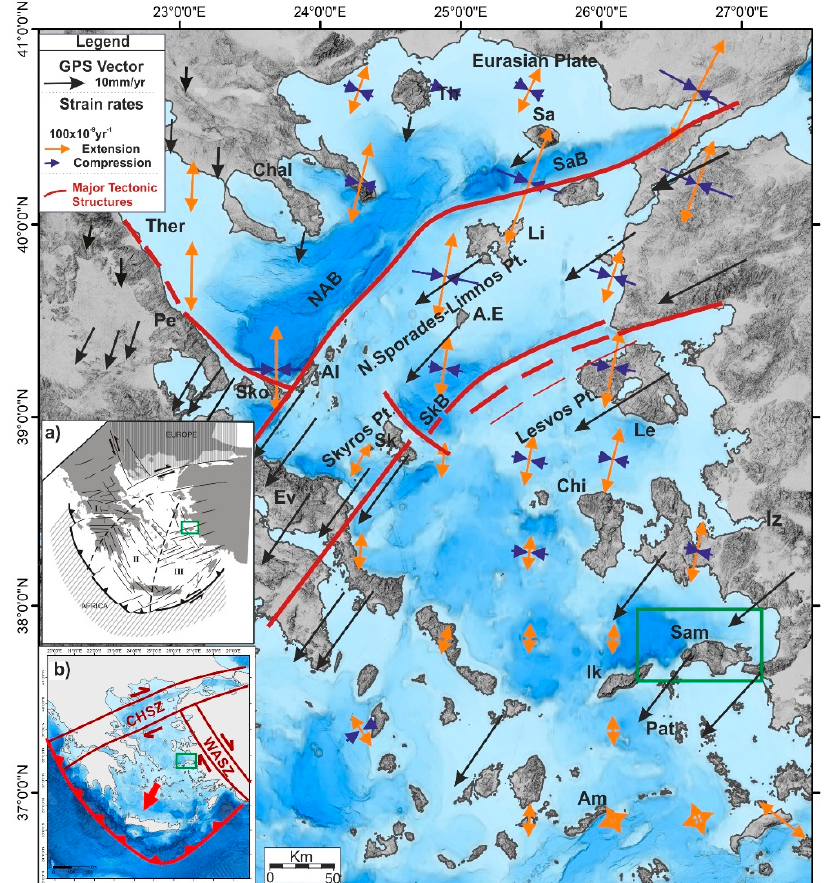
Figure 1. The location of Samos Island at the eastern Aegean Sea and the studied area in green frame. Red lines correspond to major tectonic structures and black arrows correspond to GPS vectors [16]. Orange and blue arrows correspond to geodetic strain rates [17]. A.E: Aghios Efstratios, Al: Alonnissos, Am: Amorgos, Chal: Chalkidiki, Chi: Chios, Ev: Evia, Ik: Ikaria, Le: Lesvos, Li: Limnos, Patm: Patmos, Pe: Pelion, Sa: Samothraki, Sam: Samos, Sko: Skopelos, Ther: Thermaikos, NAB: North Aegean Basin, SaB: Saros Basin, SkB: Skyros Basin, Iz: Izmir. ( a ) Insert map: the location of Samos at the eastern domain III of ENE–WSW neotectonic Aegean arc structure [18]. ( b ) Insert map: Geotectonic position of the studied area of Samos at the eastern margin of the Aegean plate, adjacent to the West Anatolian Shear Zone (WASZ) separating it from the Anatolian plate [4]. CHSZ: Central Hellenic Shear Zone.